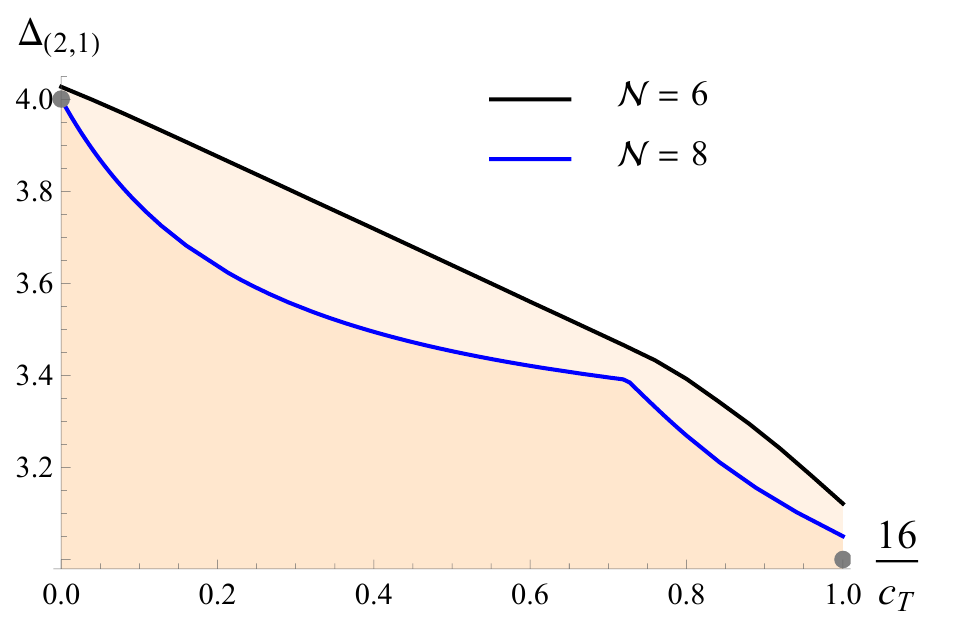
Figure 5 . Upper bound on the scaling dimension of the lowest dimension ‘ = 2 long multiplet in terms of c T for the Long [000] , 1 superconformal structure, which for parity preserving theories has ∆ , 2 the same parity as the superprimary. The orange shaded region is allowed, and the plot ranges from the GFFT limit c T → ∞ to the free theory c T = 16 . The black line denotes the N = 6 upper bound computed in this work with Λ = 39 , the blue line denote the N = 8 upper bound computed in [10] with Λ = 43 . The gray dots denote the GFFT and free theory values from table 6.